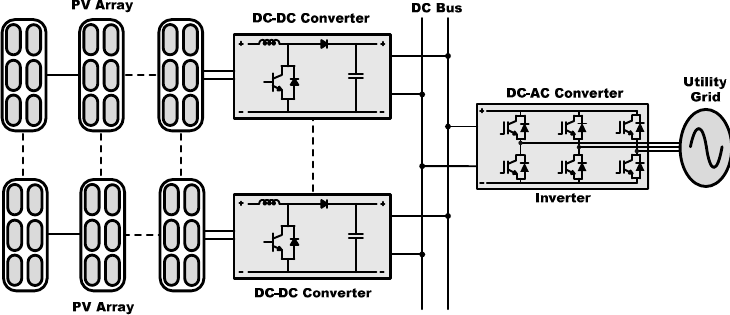
Figure 1. Centralized configuration with monopolar DC bus.